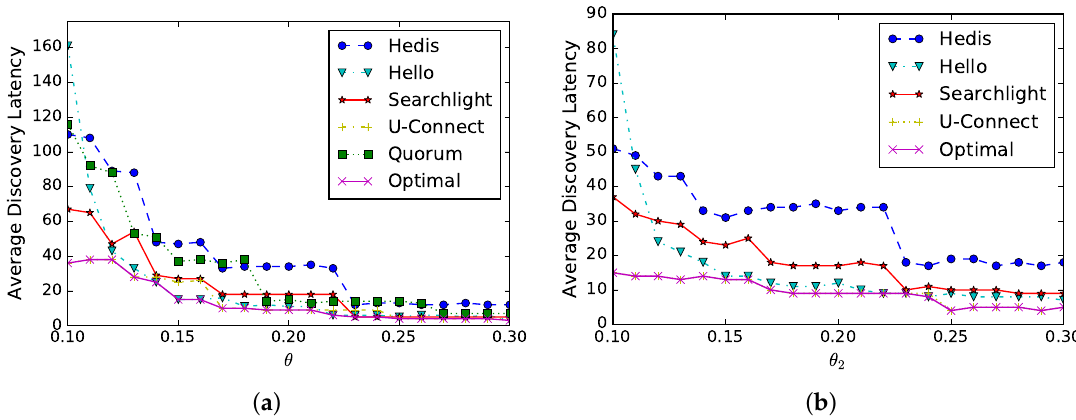
Figure 9. Spear enables the evaluation of the neighbor discovery algorithms for symmetric and asymmetric duty cycles and generates the optimal schedule automatically. ( a ) Symmetric duty cycle; ( b ) asymmetric duty